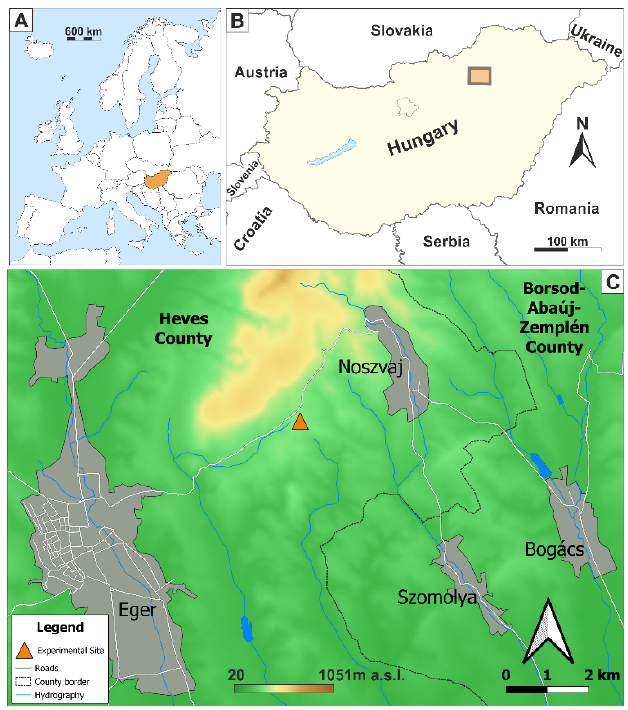
Figure 1. The Síkf ő kút DIRT Project research area (Hungary). A: Hungary in Europe; B: Síkf ő kút Figure 1. The S í kf˝ok ú t DIRT Project research area (Hungary). ( A ) Hungary in Europe; ( B ) S í kf˝ok ú t Proejct in Hungary; C: Location of Síkf ő kút Project Proejct in Hungary; ( C ) Location of S í kf˝ok ú t